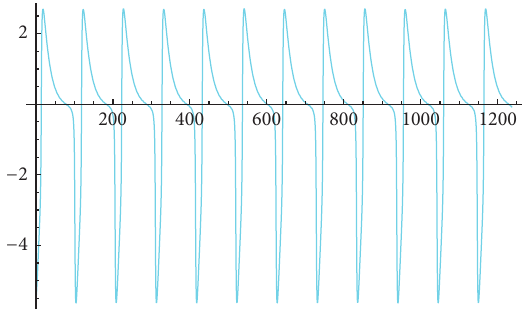
Figure 1: Periodic solution of (52) with delayed condition 𝑢(𝑥) = −5.5 (𝑥 ≤ 0) and initial condition 𝑢 󸀠 (0) = 0 .